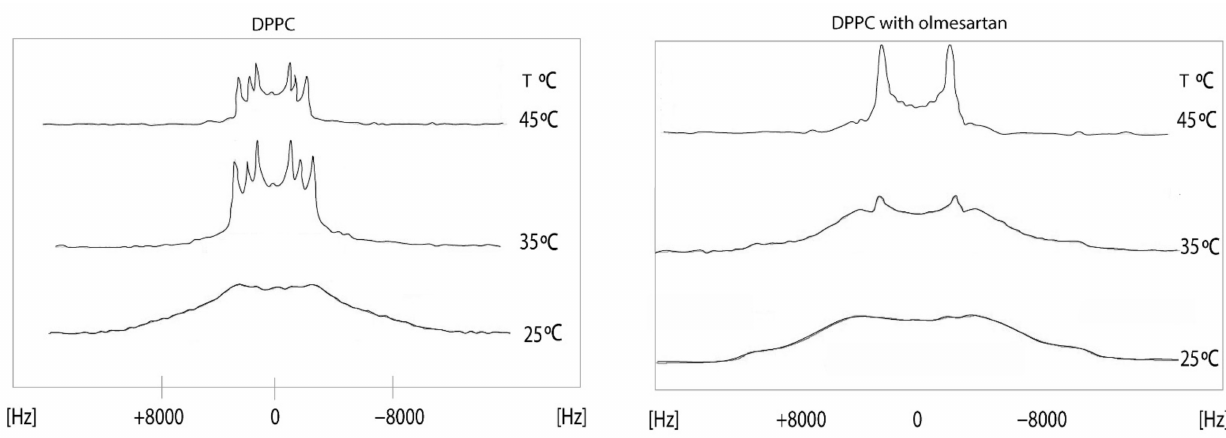
Figure 6. 2 H NMR spectra of 1,2[2,2- 2 H]-DPPC bilayer ( left ) at a temperature range of 15–45 ◦ C and 1,2 [2,2- 2 H]-DPPC bilayer with olmesartan (20% molar ratio) was added ( right ). 2 H solid-state NMR spectra were recorded on a BrukerAvance 600 MHz WB spectrometer equipped with a 4 mm HX double resonance MAS probe. Spectra were recorded without spinning the 4 mm MAS rotor using a solid echo sequence with an echo delay of 35 µ s and a pulse length of 2.5 µ s [45].